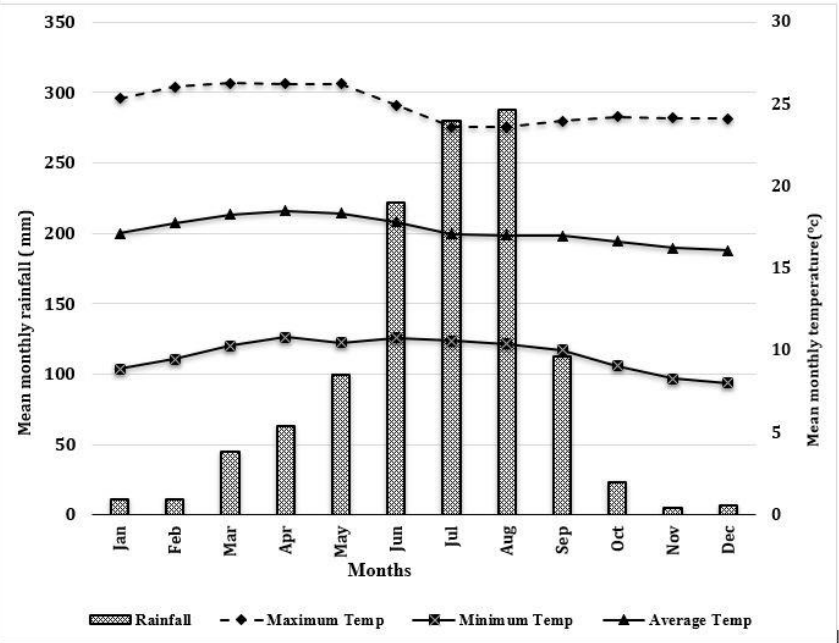
Fig. 2. Rainfall and temperature records of the study area based on the records of nearby Tulu Bolo station (1990–2019) from the national meteorological service agency,